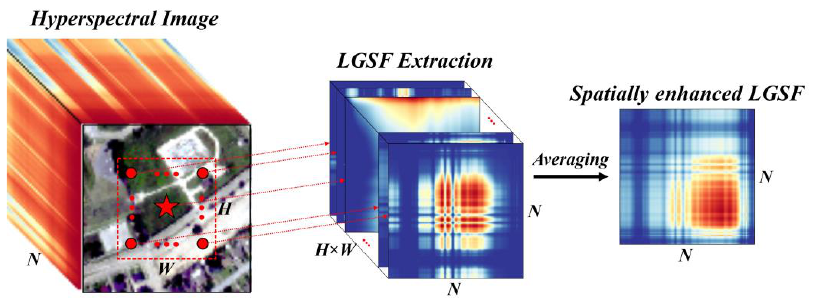
Figure 6. The spatial enhancement process of LGSF.